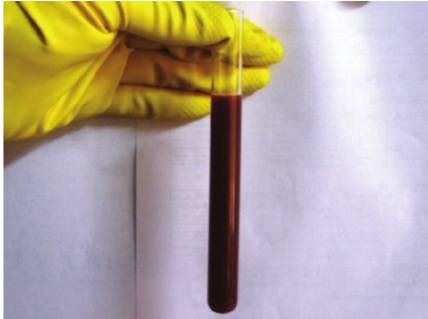
Figure 3: Gross appearance of the abdominal e ff usion (septic exudate) obtained under ultrasound guidance from 6-year-old male Labrador Retriever a ff ected with infectious peritonitis.